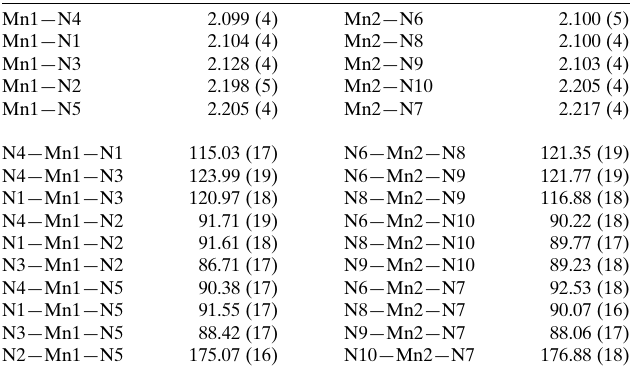
Table 2 Selected geometric parameters (A˚ , (cid:3) ) for compound 2 .